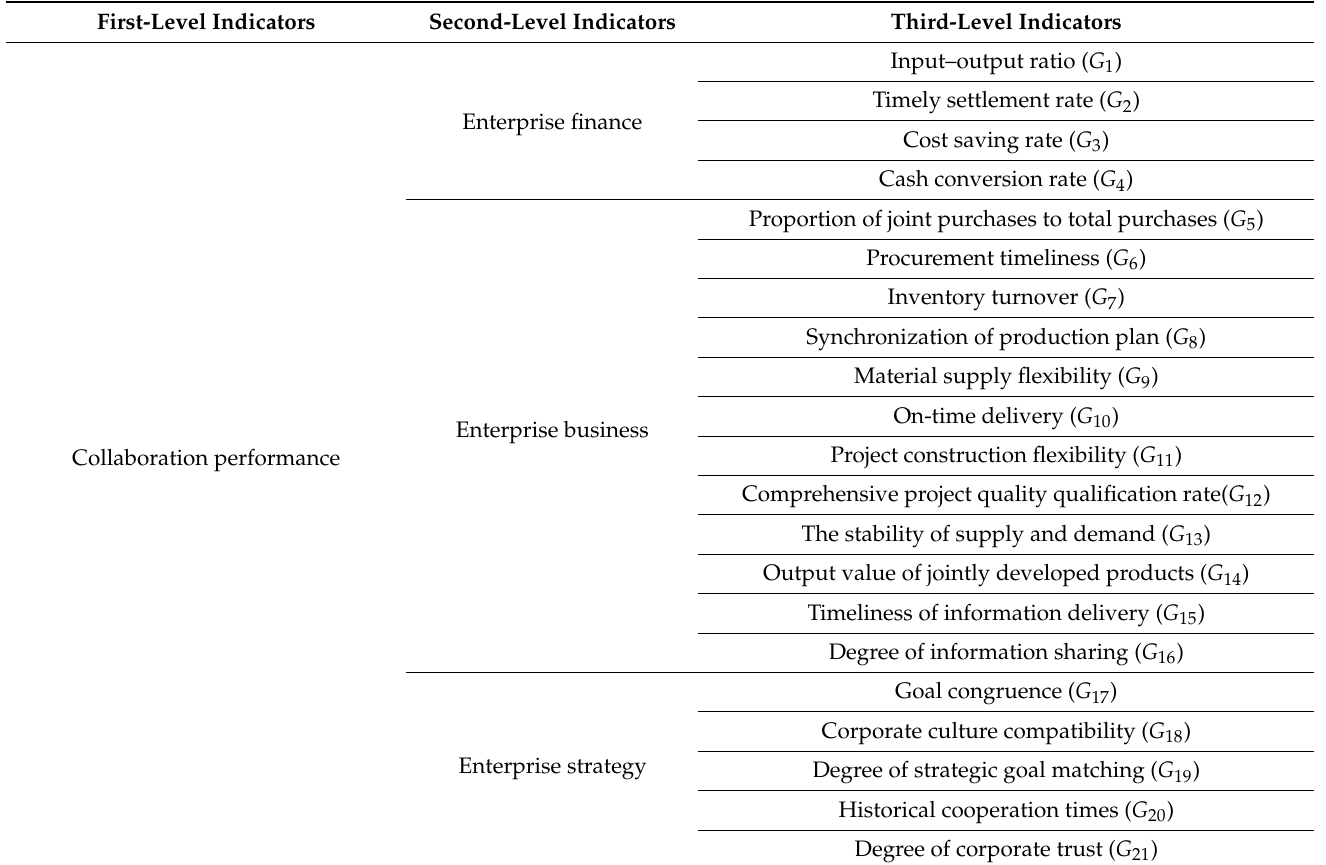
Table 1. Enterprise collaboration performance evaluation index